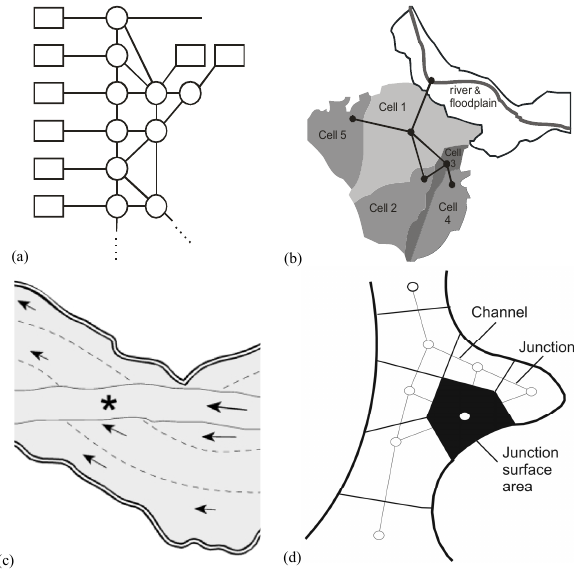
Fig. 1. Examples of quasi-2-D modelling approaches: (a) a portion of the Mekong Delta model with cells (circles) and boundary condi- tions (rectangles) (Cunge, 1975), (b) extended floodplain of the Po River with five cells (Aureli et al., 2006), (c) floodplain discretised as streamtubes between dashed lines with mixing occurring in the main channel (indicated by *) (Asselmann and van Wijngaarden, 2002) and (d) 1-D hydrodynamic channel-junction network allow- ing a 2-D spatial representation of inundated areas (Ambrose et al.,